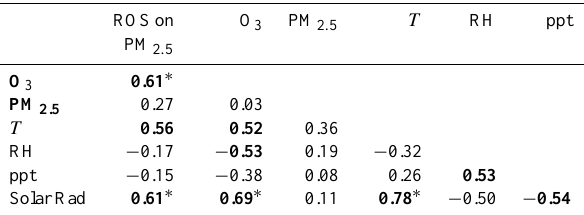
Table 1. Spearman’s rank correlation coefficients between the con- centration of ROS on PM 2 . 5 (ROS), ozone concentration (O 3 ) , PM 2 . 5 concentration, temperature ( T ), relative humidity (RH), pre- cipitation (ppt), and solar radiation measured at the nearest TCEQ site (Solar Rad). Significant relationships at p < 0.01 are in bold and those at p < 0 . 001 are further denoted with ∗